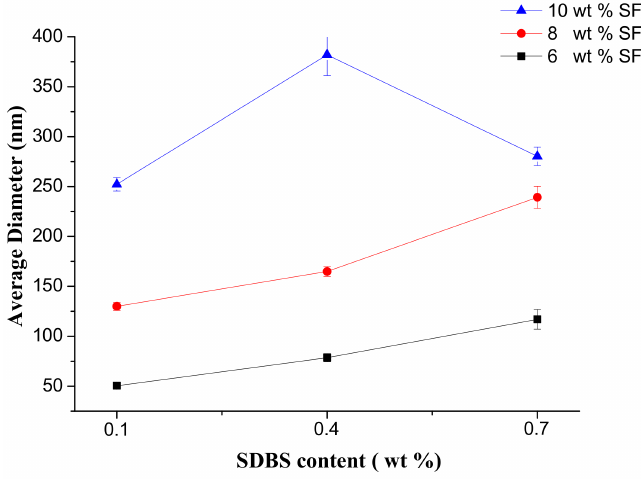
Figure 8. Average diameter of SF nanofibers when the gas flow volume was 50 m 3